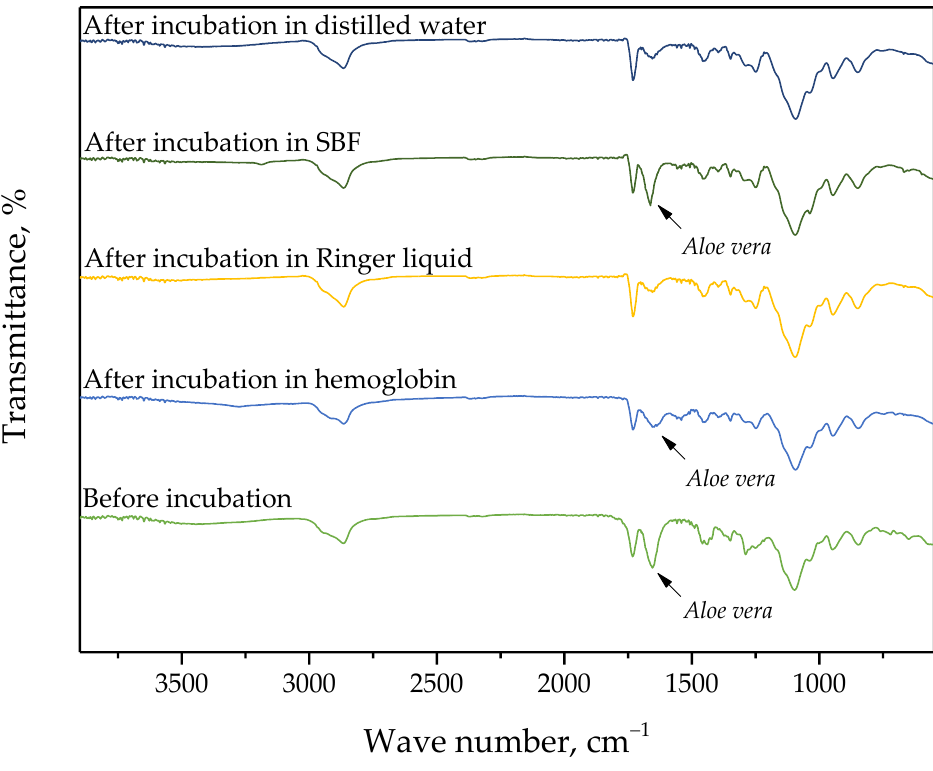
Figure 6. FT-IR spectrum of sample 0.150/Photo.